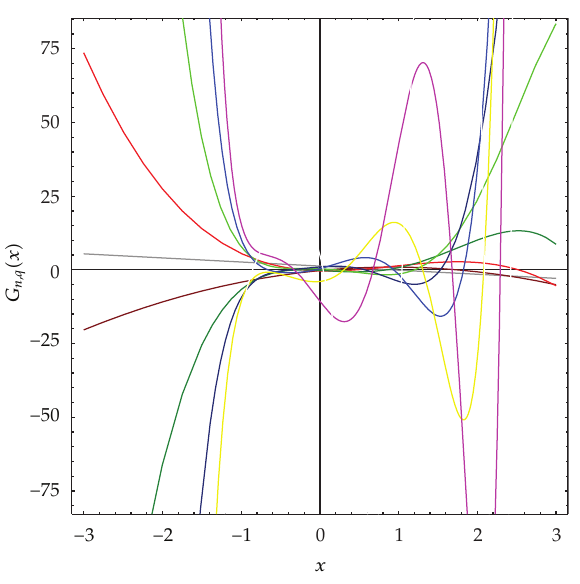
Figure 3: Curves of G n, 1 / 4 (cid:2) x (cid:3)